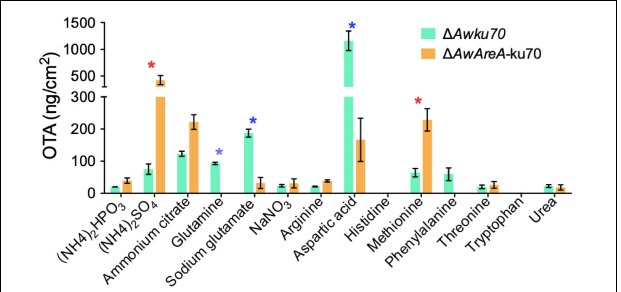
FIGURE 6 | Ochratoxin A (OTA) production of (cid:49) Awku70 and (cid:49) AwAreA- ku70 on media containing different nitrogen sources. The asterisk in red/blue color indicates a significant increase/decrease between the corresponding values ( p < 0.01) with three biological